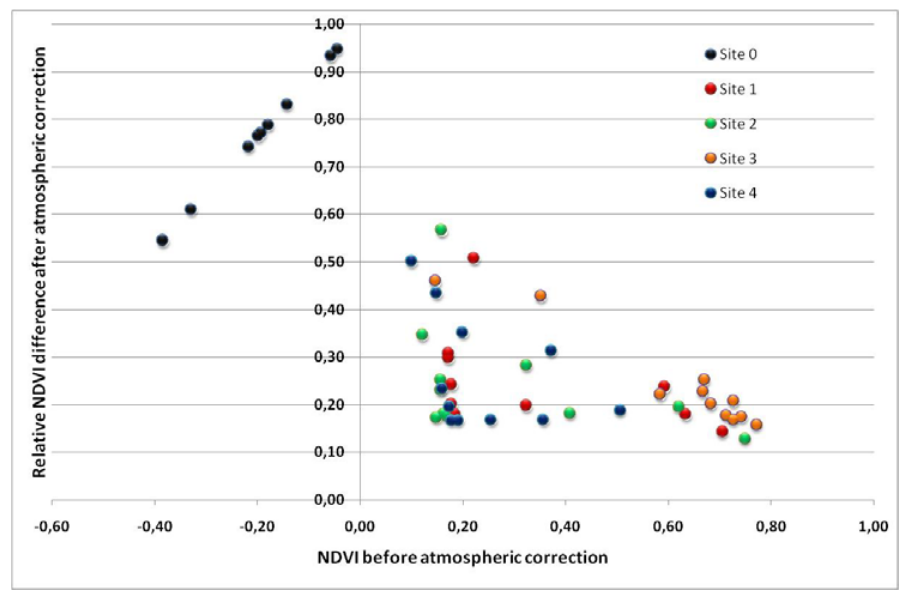
Figure 7. Relative NDVI values after atmospheric correction (modified DP) against NDVI values before atmospheric